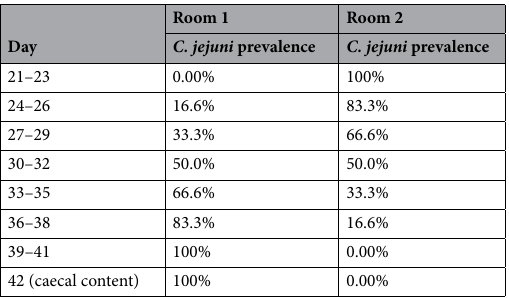
Table 1. C. jejuni prevalence in cloacal swabs as well as in caecal content at day